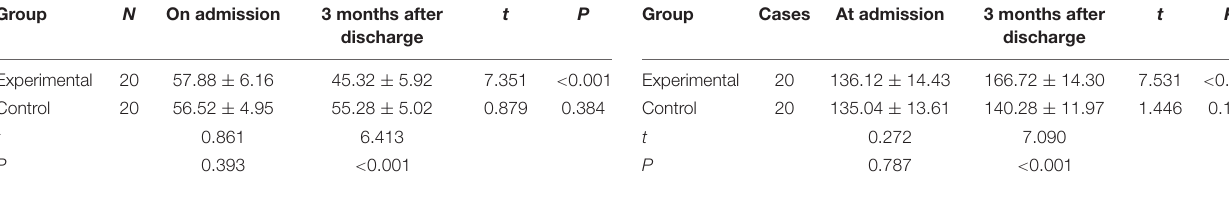
TABLE 2 | Comparison of SAS scores of two groups of patients with IBD at admission and 3 months after discharge ( (cid:83) x ± s). Group N On admission 3 months after Experimental